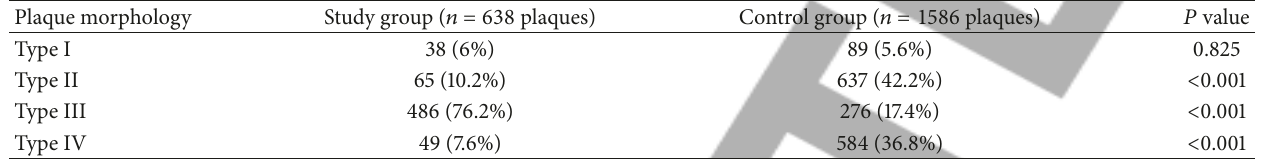
Table 4: Comparison of plaque morphology between study and control